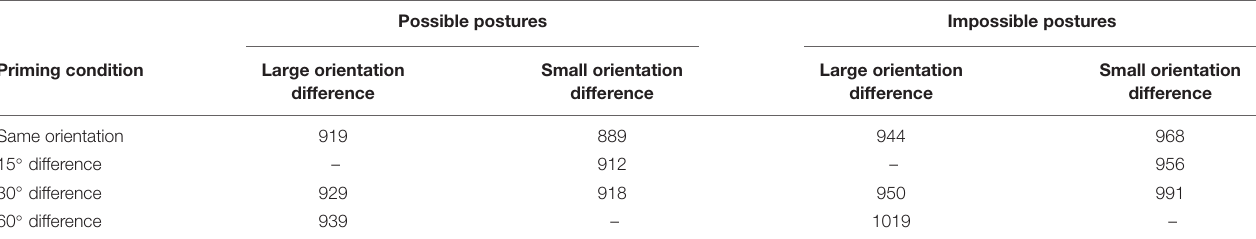
TABLE 4 | Mean identification time (in ms) of possible and impossible human postures in the priming phase of Experiment 3 as a function of context condition (large vs. small orientation differences) and long-term priming condition (same orientation, 15 ◦ , 30 ◦ , or 60 ◦ difference). Possible